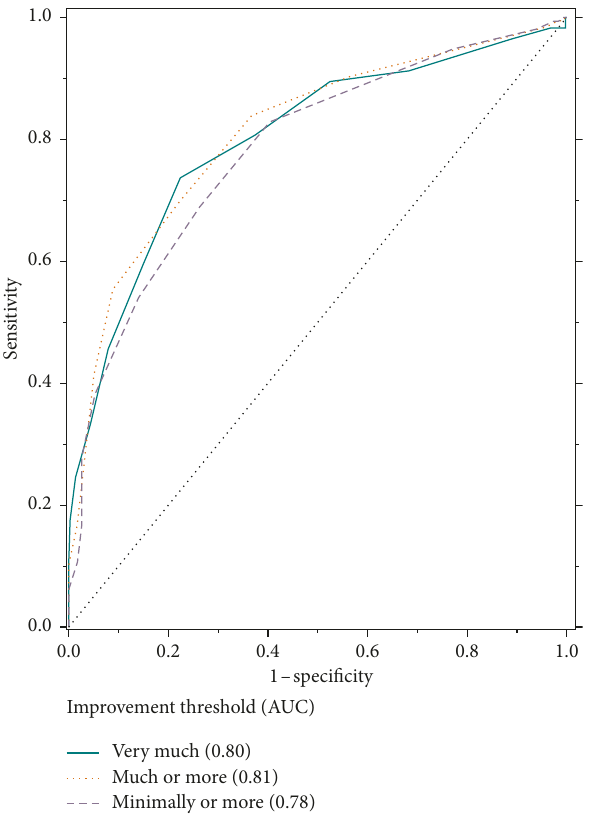
Figure 3: ROC curve of percentage change in the m-BPI-WPS score from the baseline to week 5/end of the study and PGIC. AUC, area under the curve; m-BPI-WPS, modified Brief Pain Inventory- worst pain severity; PGIC, patient global impression of change; ROC, receiver operating